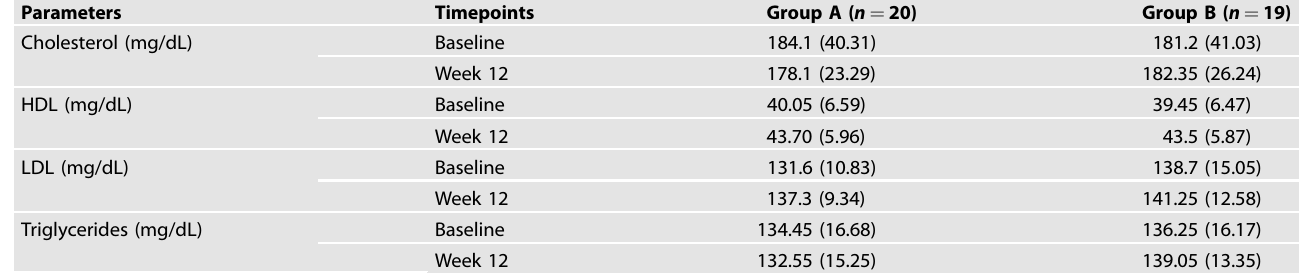
Table 3. Lipid pro fi le.